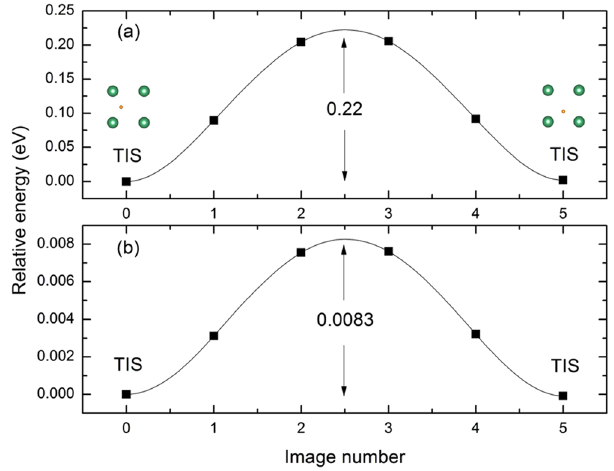
Figure 2. Energy barriers of H diffusion from TIS to TIS in ( a ) Nb and ( b ) Nb 15 Ni.